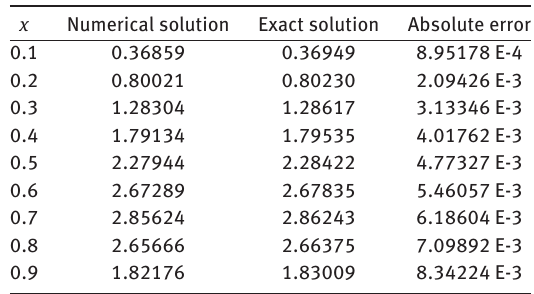
Table 1: The numerical resultes for first problem at y = 0.5, x , y ∈ [0, 1]